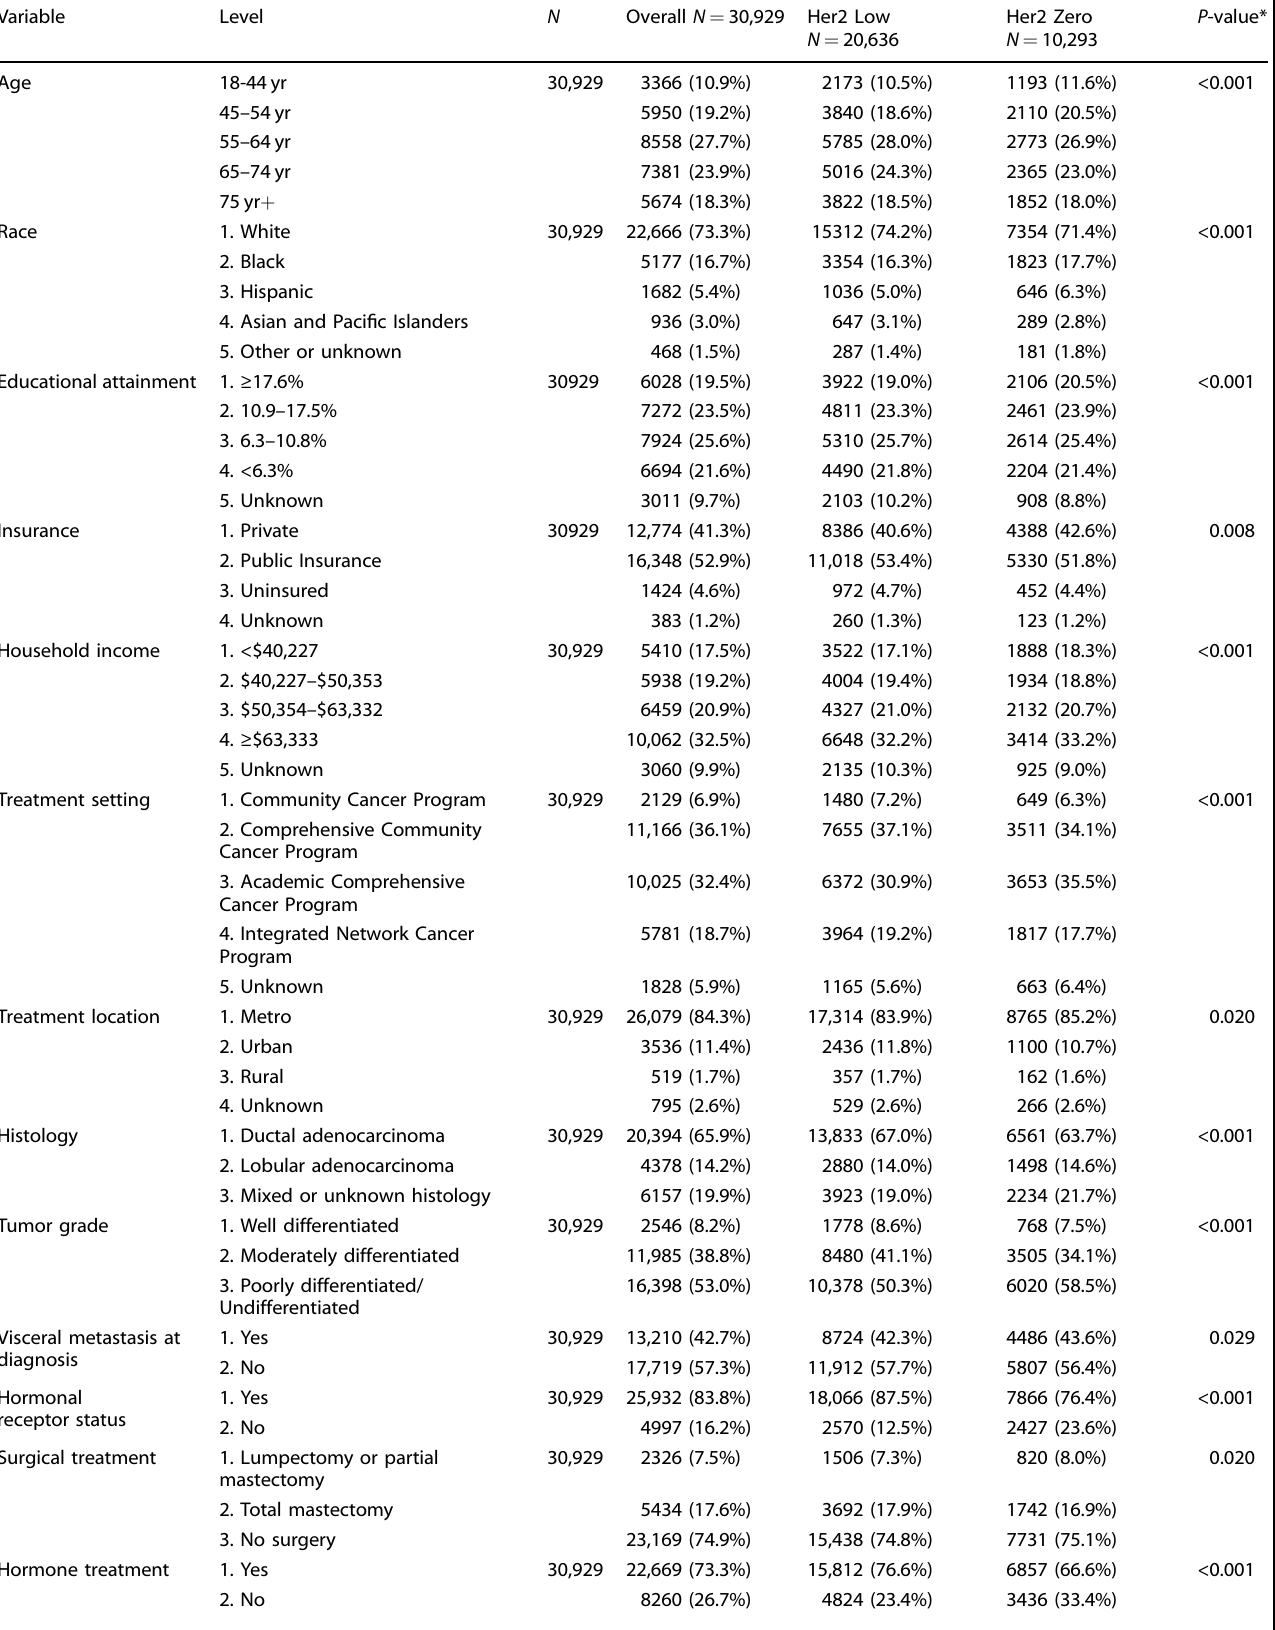
Table 1. Characteristics of patients with HER2-low and HER2-zero metastatic breast